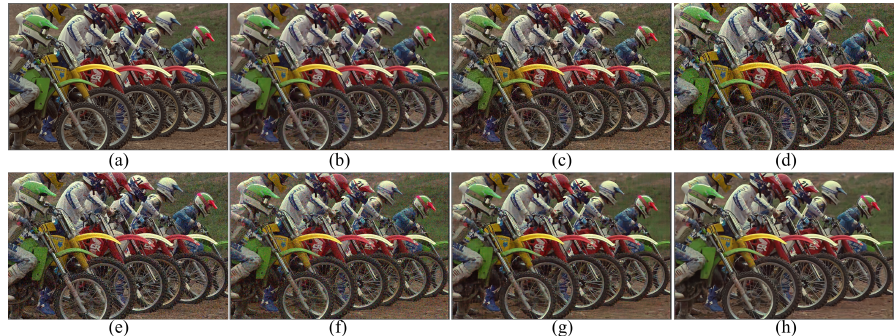
Figure 6. Reconstruction results for the Kodak number 5 image with noise levels σ R = 26.22, σ G = 16.64 and σ B = 18.23. ( a ) Original, ( b ) ADMM, [28] ( c ) SEM, [14] ( d ) DNetB, [15] ( e ) DNetX, [15] ( f ) DIP, [19] ( g ) proposed and ( h ) proposed + BM3D.